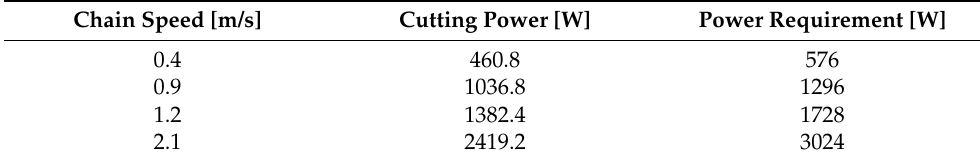
Table 1. Cutting forces and cutting powers. The chip area is a constant A chip = 4 mm 2 .